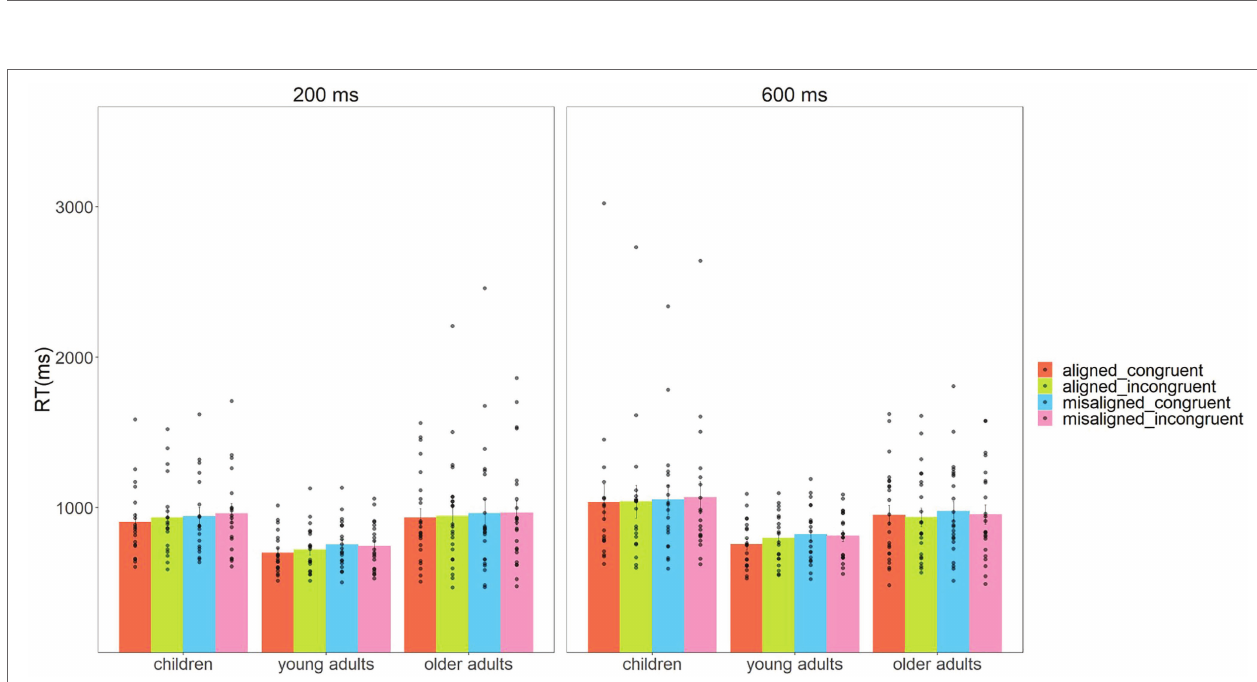
FIGURE 2 | Mean sensitivities (A ' ) and standard errors for alignment, congruency, and stimulus presentation duration as a function of children, young adults, and older adults.